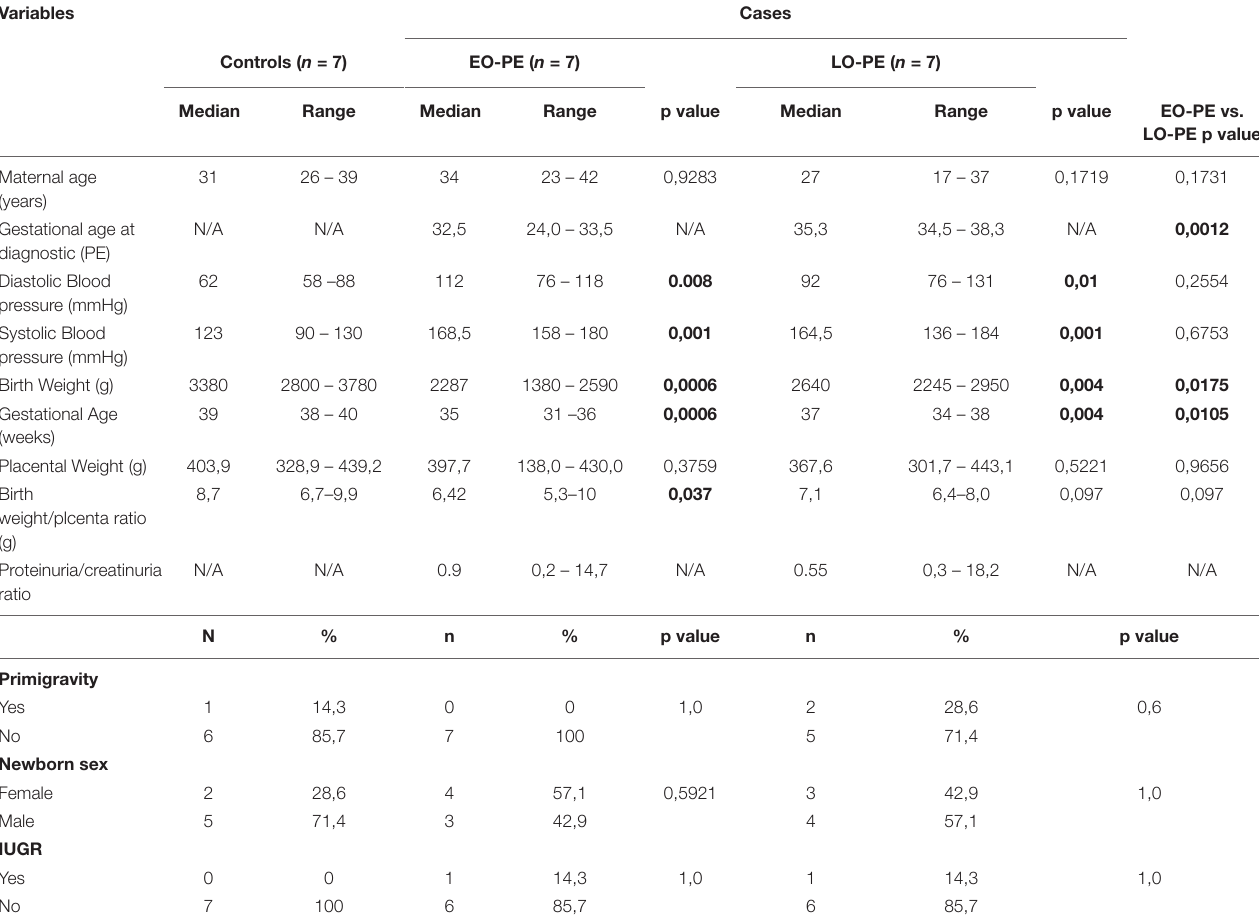
TABLE 1 | Clinical and demographic characteristics of the